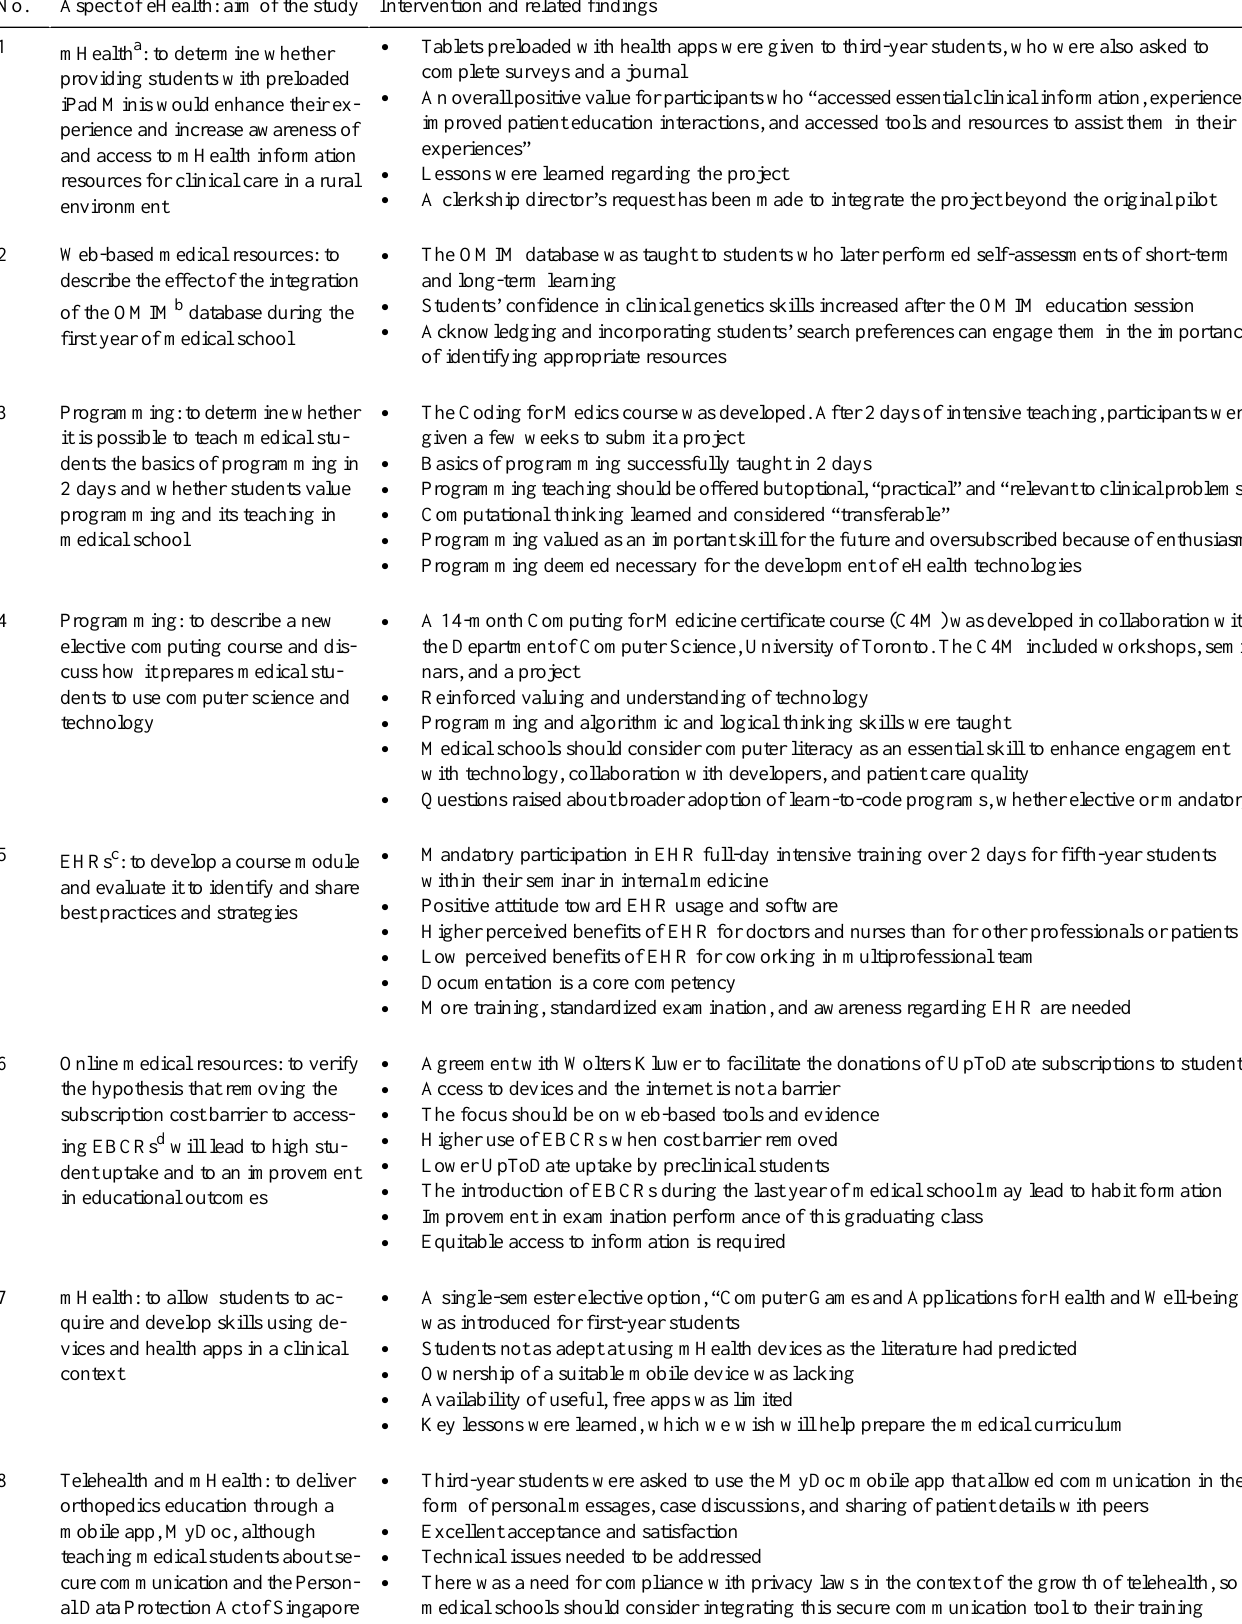
Intervention and related findingsAspect of eHealth: aim of the